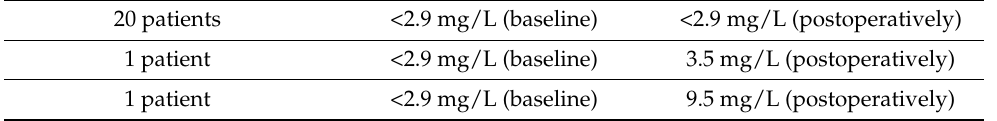
Table 3. Variations in serum CRP